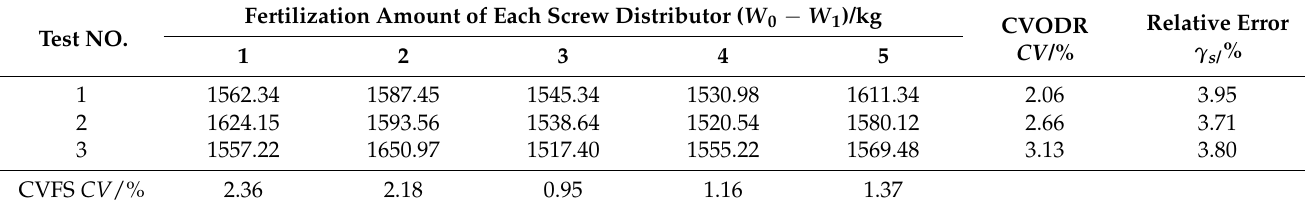
Table 9. Results of field